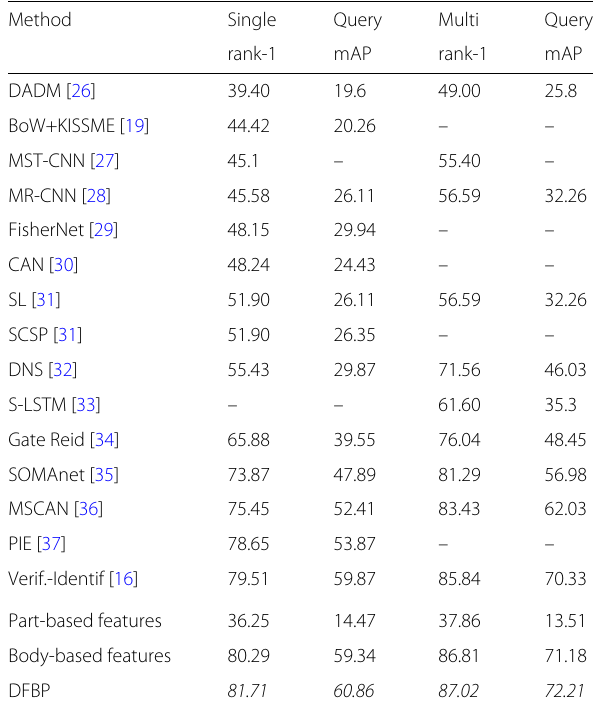
Table 1 The rank-1 precious (%) and mAP (%) on the Market-1501